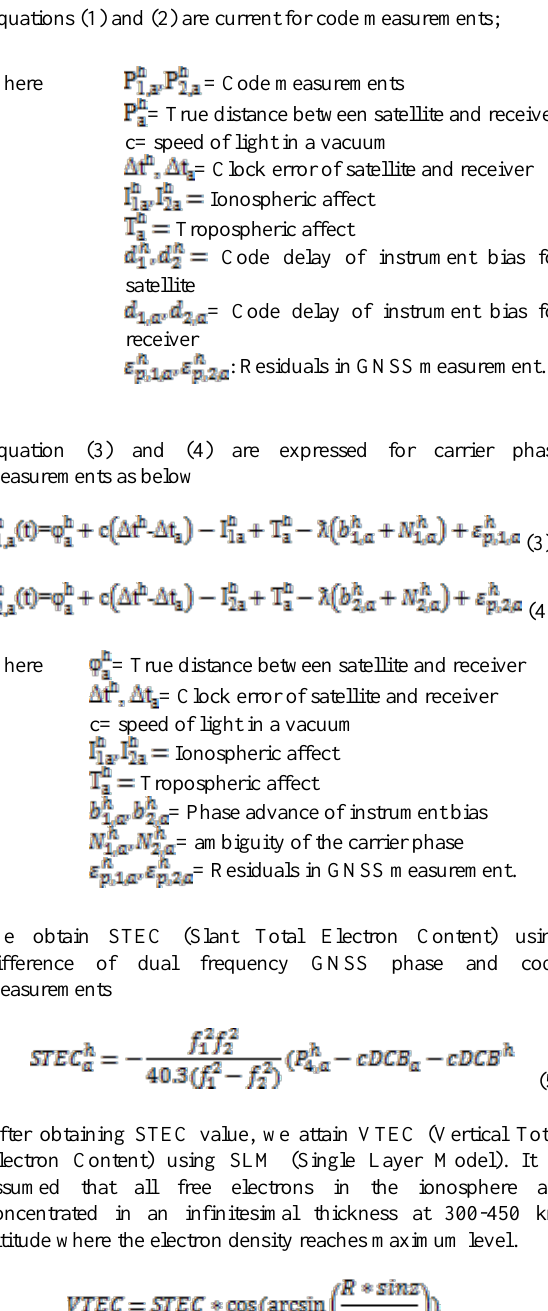
Figure 1. CORS-TR RINEX data is downloaded URL-1, IGS